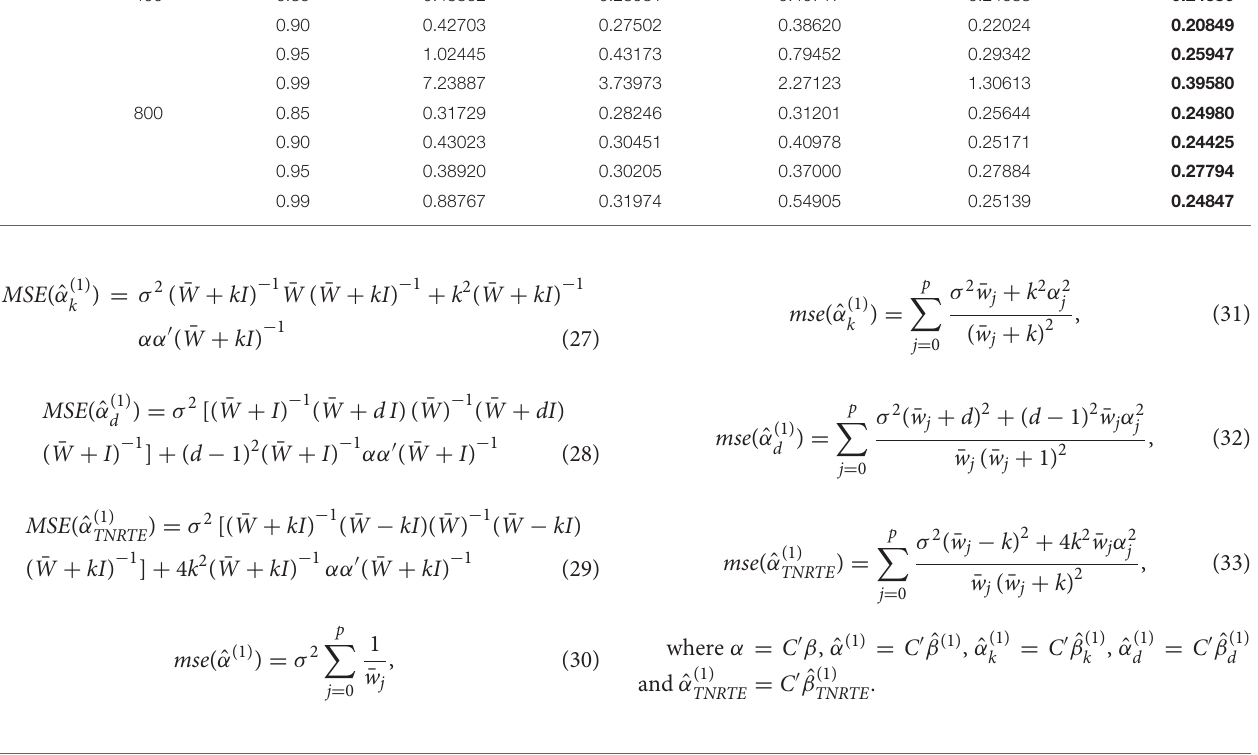
TABLE 3 | Simulation results in case of p